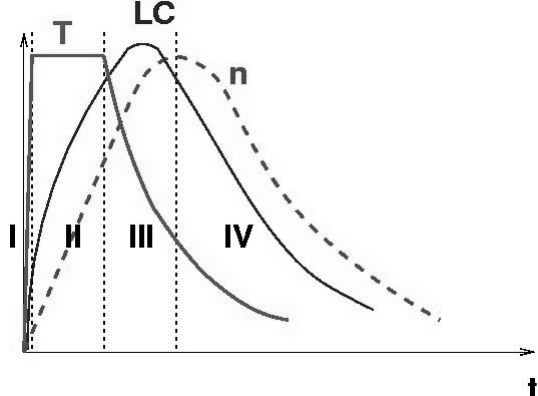
Figure 15: Scheme of the evolution of temperature (T, thick solid line), X-ray emission, i.e., the light curve (LC, thinner solid line) and density (n, dashed line) in a loop strand ignited by a heat pulse. The strand evolution is divided into four phases (I, II, III, IV, see text for further details). Image reproduced with permission from Reale (2007), copyright by